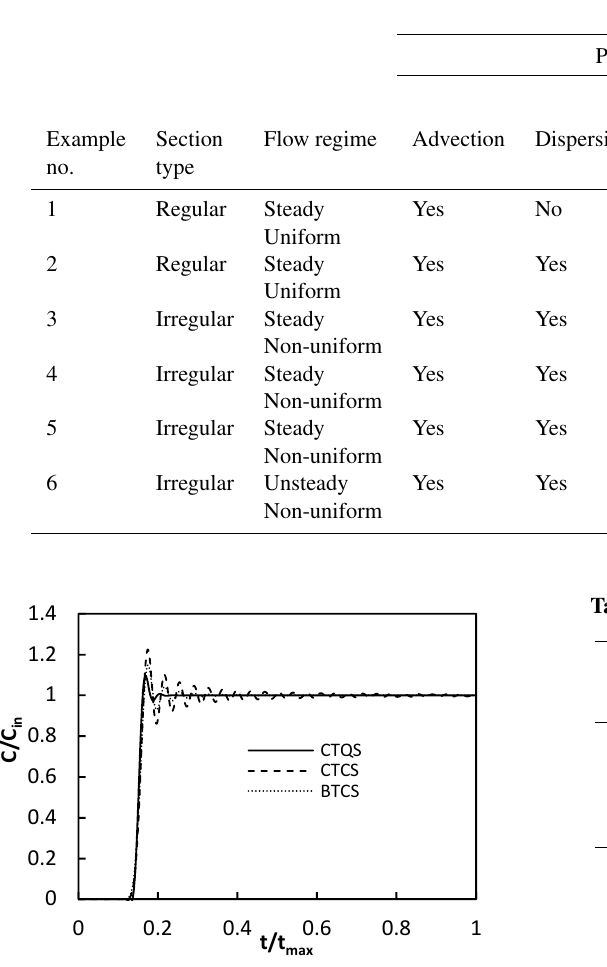
Figure 8. Comparison of the CTQS, CTCS and BTCS schemes for the pure advection test case.